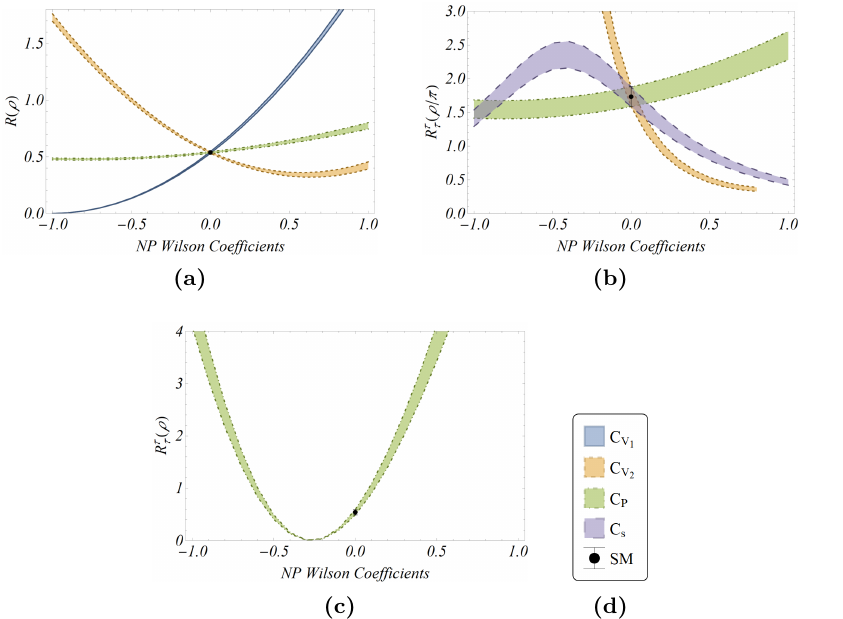
( ρ/π ) and R µ ( ρ ) w.r.t. new WC’s (real), taken τ τ